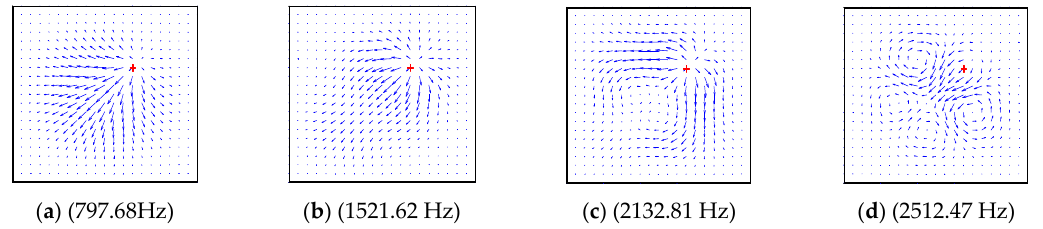
Figure 14. The power flow field for a CCCC laminated plate excited by point force on (0.65 m, 0.65 m). ( a ) (797.68Hz), ( b ) (1521.62 Hz), ( c ) (2132.81 Hz), ( d ) (2512.47